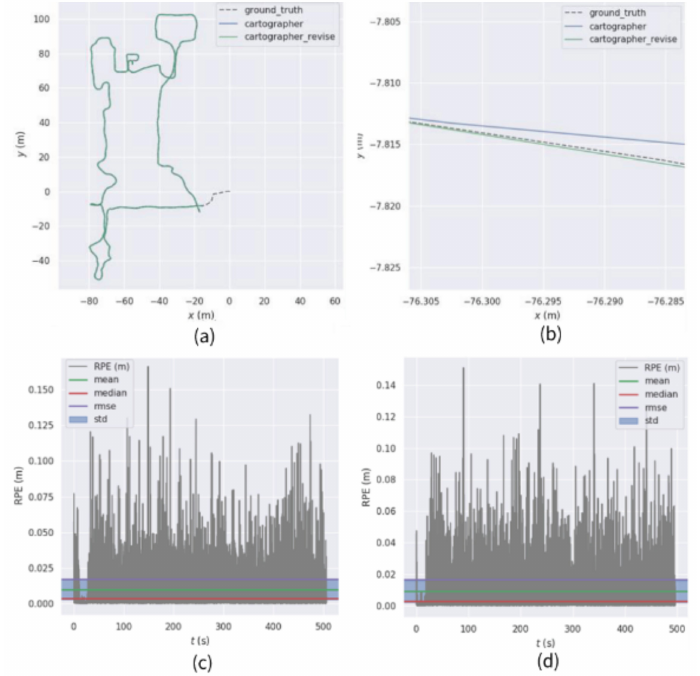
Figure 9. Comparison of relative trajectory errors of sequence 2 (cid:13) . ( a ) Cartographer, improvement scheme, and real trajectory comparison ( b ) Local trajectory map ( c ) Absolute trajectory error of Cartographer ( d ) Absolute trajectory error of the improved scheme.